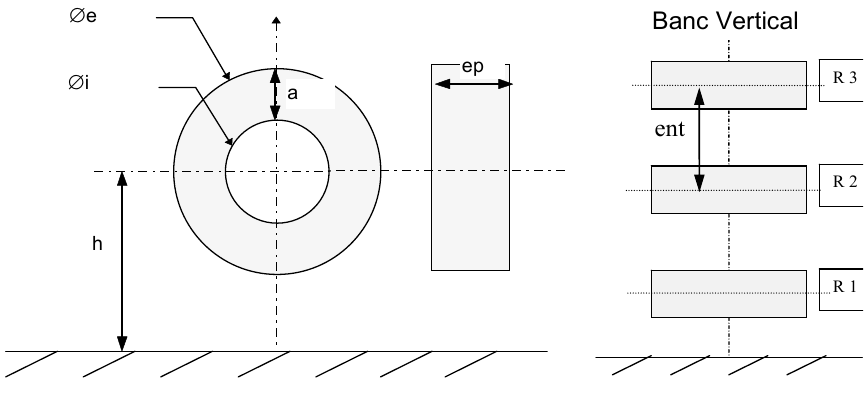
Figure 6. Parameters of three reactances.